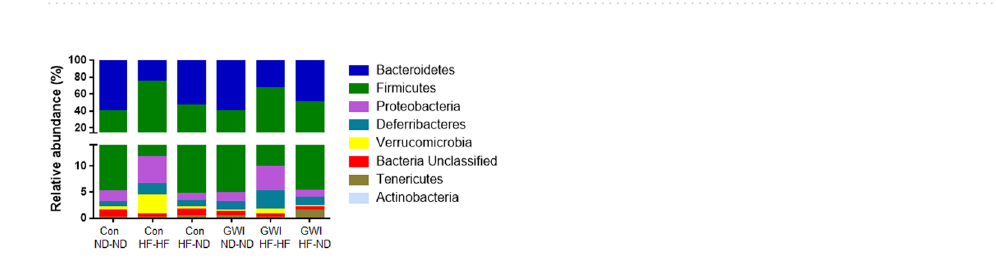
Figure 6. Bacterial taxa that were differentially abundant across treatments. LEfSe was carried out using the Galaxy Project and the results are displayed in the bar charts ( A ) and the associated cladogram ( B ). Taxa showing different abundance values in each treatment group (according to LEfSe) are shown in the cladogram highlighted by small circles and by shading. All groups are statistically significant compared to each other (LDA > 3.6). Con = control; GWI = PER + PB; ND = normal diet; HF = high fat diet.